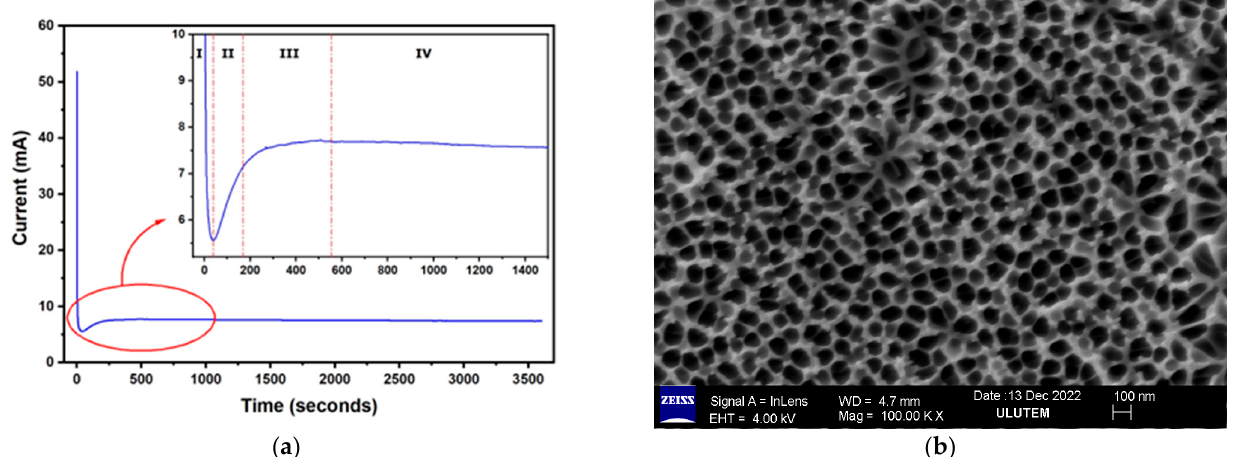
Figure 1. ( a ) The current versus time profile during electrochemical etching. ( b ) SEM images of synthesized AAO nanopores.